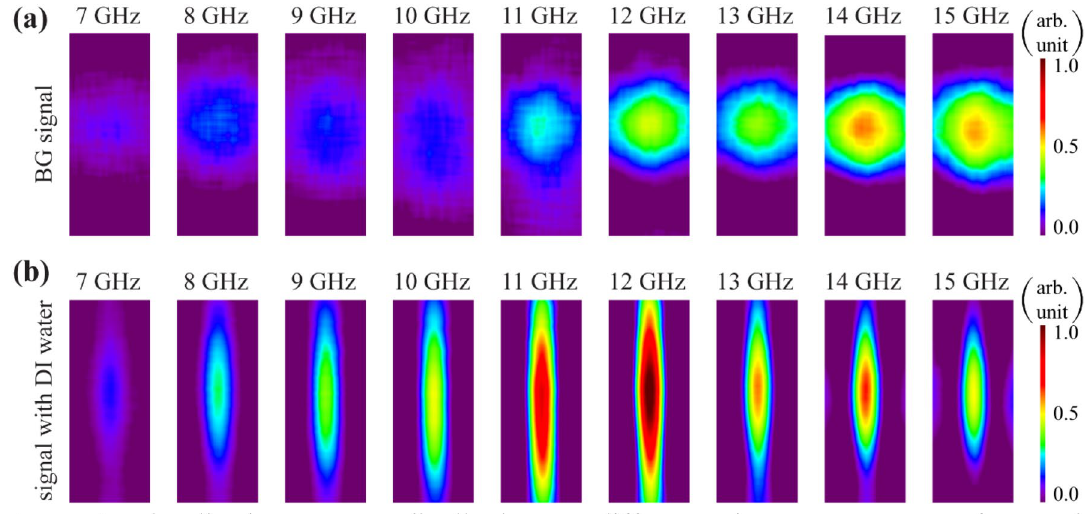
Figure 4. Visualized H-MWNF distributions at different microwave exposure frequencies when the plastic tube was empty ( a ) and filled with DI water ( b ). Size of each image is 20 mm × 8 mm.